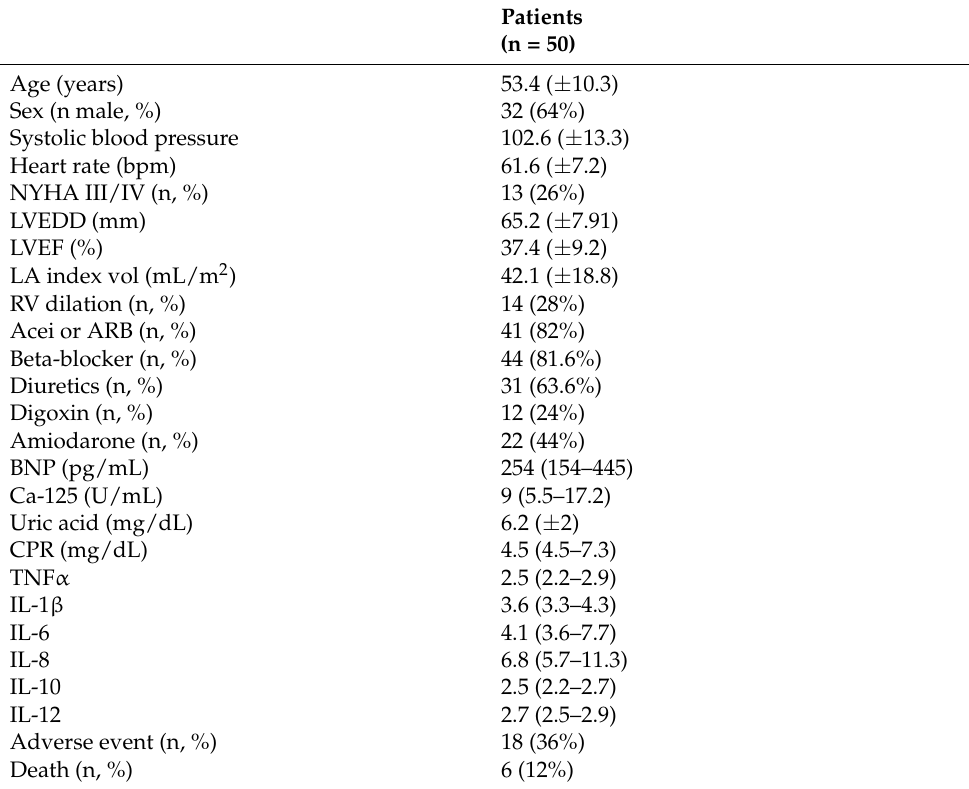
Table 1. Patients